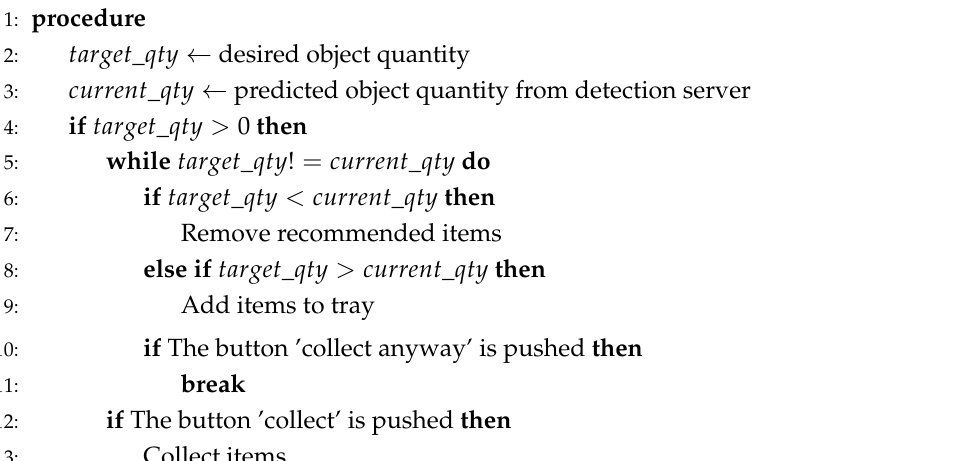
Algorithm 2 Smart count system-UI